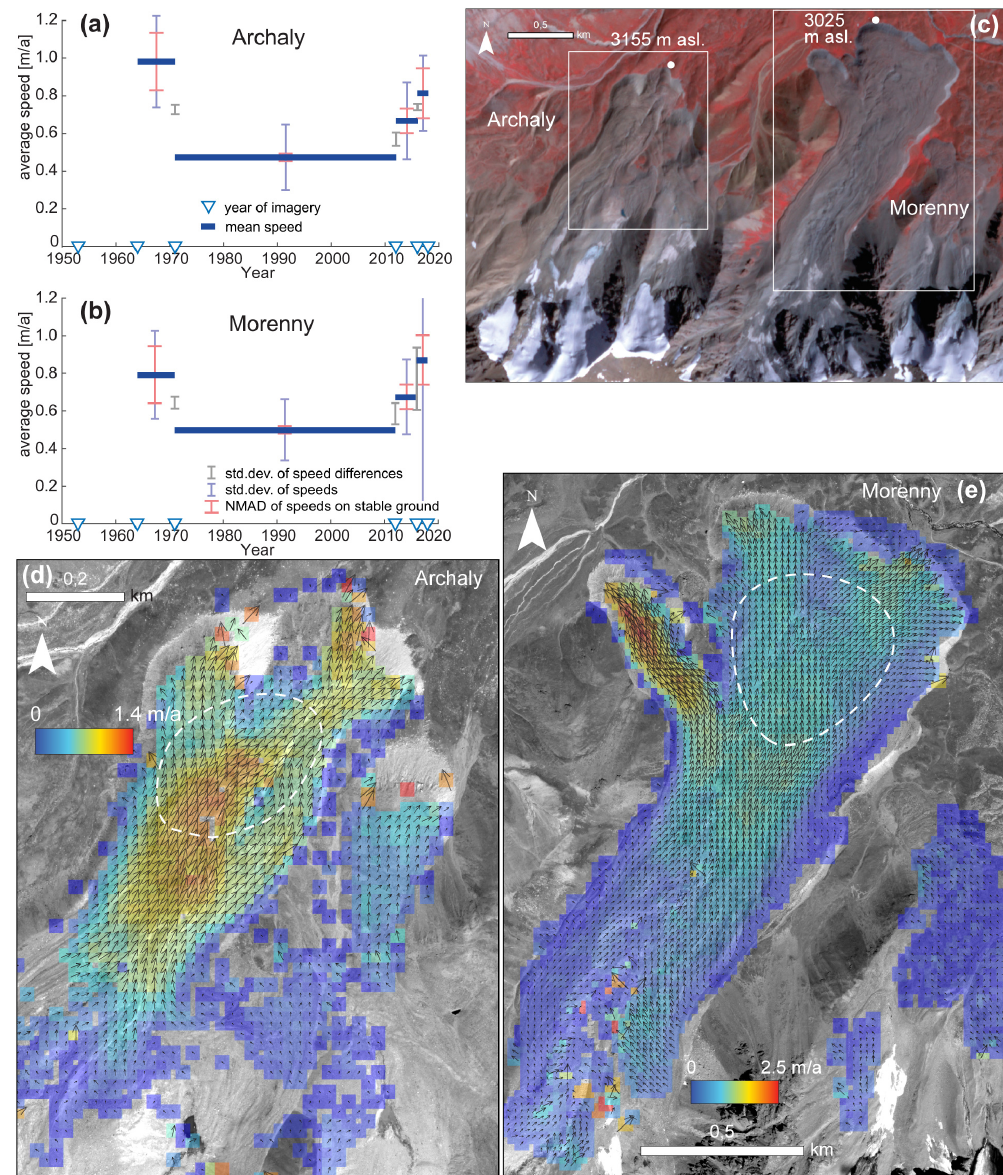
Figure 4. Velocities and speed variations on the Archaly and Morenny rock glaciers. (a, b) Average time series of speeds for clusters of points (white dashed outline in panels d and e ). Error bars give normalized median absolute deviations (NMADs) of stable ground speeds (red), standard deviations of speeds within the point cluster (blue), and standard deviations of speed differences within the measurement periods (grey) in m/a. Blue triangles on the time axis indicate years of imagery used. (c) Overview image; © Planet image on 7 September 2016 in near-infrared false colour. (d, e) Colour-coded velocity fields with vectors superimposed from image matching between 2012 and 2016 high-resolution satellite images (for exact dates and sensors see Table S2). Background image: Pléiades, 27 August 2016, © CNES (2016), and Airbus DS